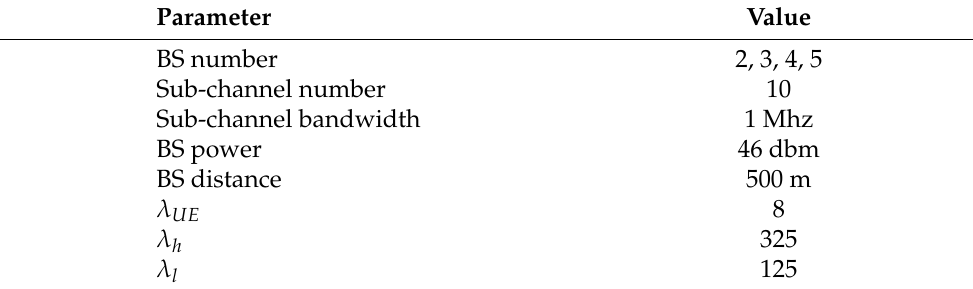
Table 3. Simulation parameters of wireless environment.